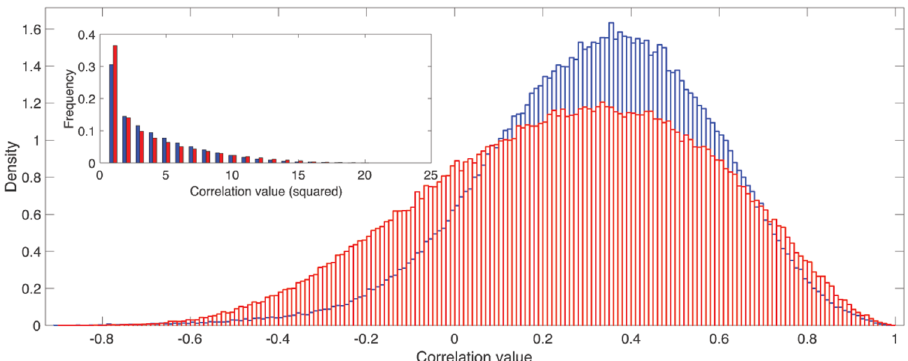
Figure 6. Weights distribution comparison. The density of the distributions of the human functional brain networks’ correlation values for healthy subjects (blue) and schizophrenic patients (red). Inset: distribution of the squared correlation